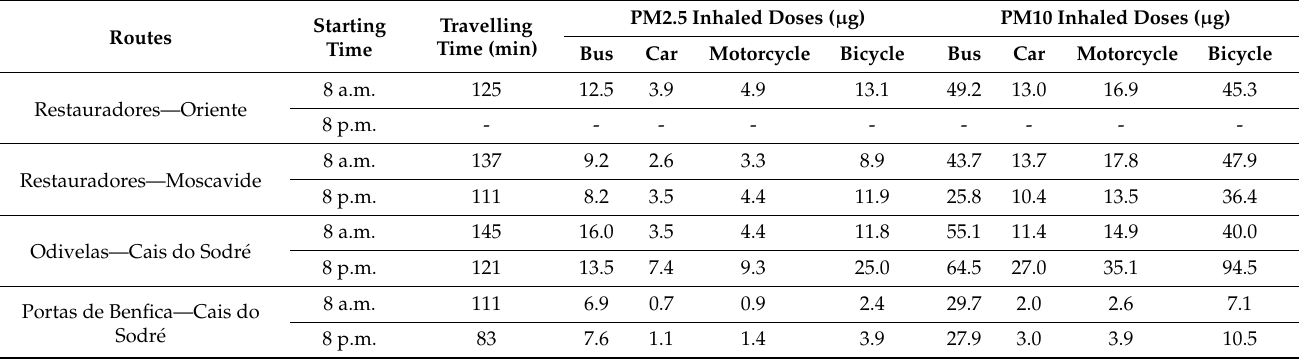
Table 4. PM2.5 and PM10 inhaled doses ( µ g) for each selected route during a two-way